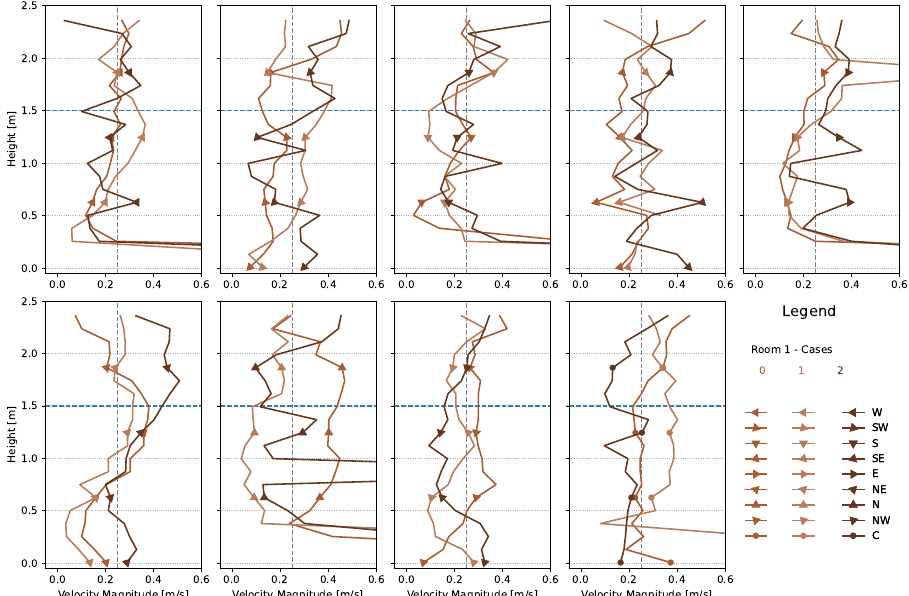
Figure 11. Velocity profiles were computed for each pillar inside Room 1. They vary per case (indi- cated by changing color tones) and pillar position (indicated by direction markers). The orientation of the plots is from top left to bottom right. They are associated with the anti-clockwise direction beginning at the West (W) position. The vertical dashed line in gray marks the abscissa of the velocity value recommended by regulations (0.25 m/s). The horizontal dashed line in blue indicates the ordinate of the regulatory height where we took measurements (1.5